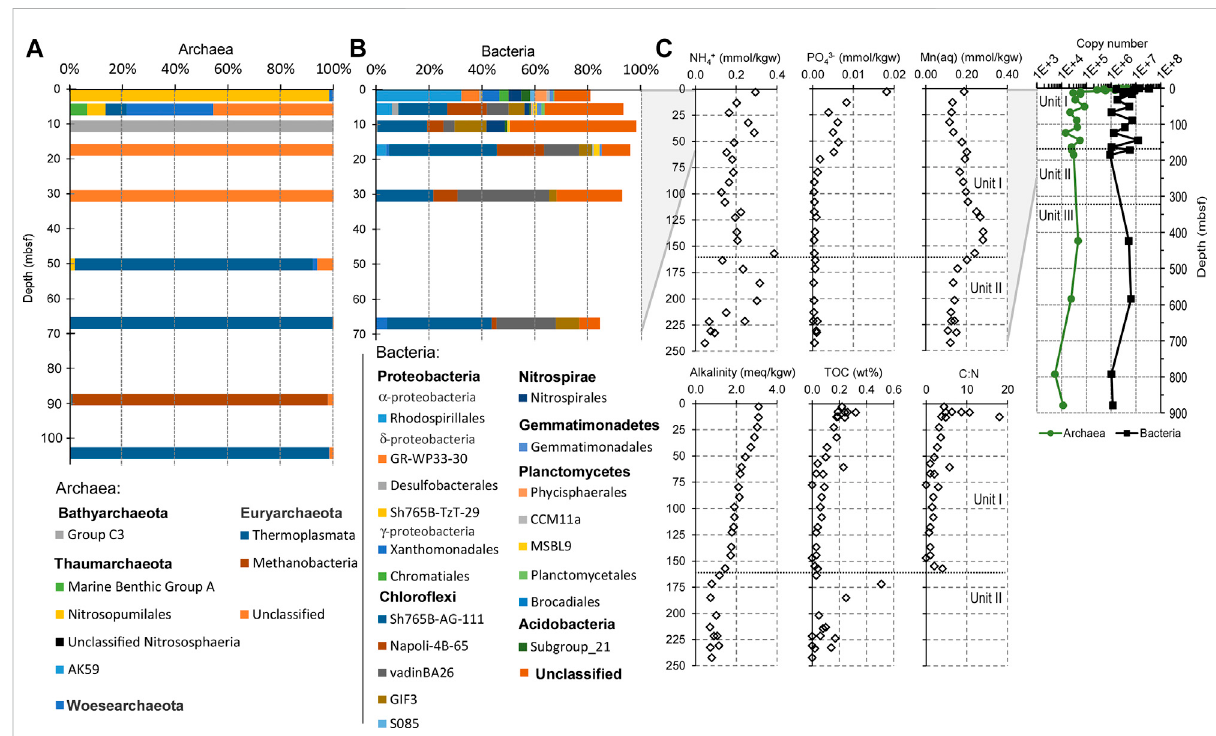
FIGURE 5 (A) Depth pro fi les of the relative abundance of the most abundant Archaeal groups at class level, Woesearchaeota phylum and unclassi fi ed OTUs at class level. (B) Depth pro fi les of the most abundant Bacterial groups and unclassi fi ed OTUs at order level. (C) Depth pro fi le of total abundance (copy number) of Archaea and Bacteria; and selected geochemical variables. The tabular data shown in these plots is given in. tsv fi les (tab-separated values), in Supplementary Material